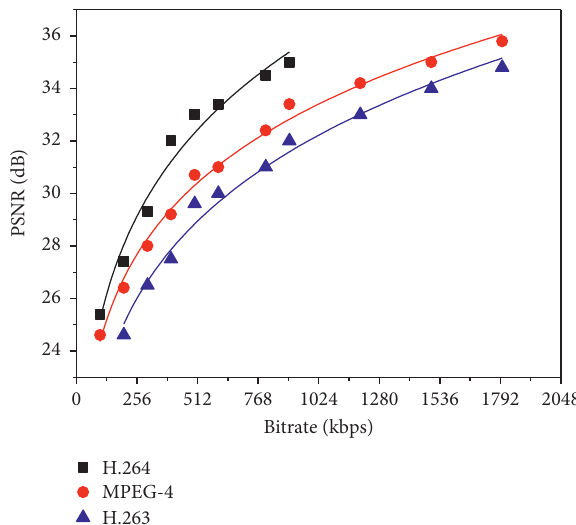
Figure 8: Encoder performance